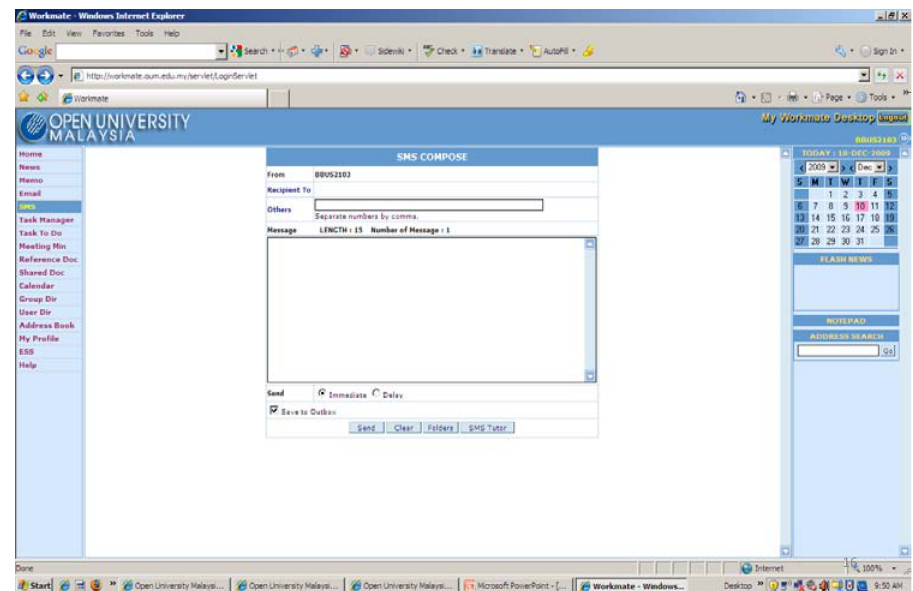
Figure 5. Screen capture of OUM’s Workmate (Group messaging